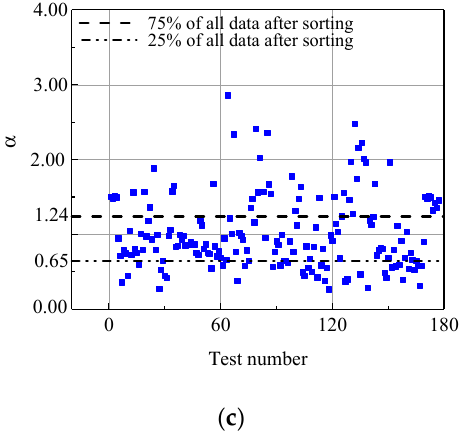
Figure 1. Soil properties of samples: wet density ( a ); plasticity index ( b ); D 50 ( c ); percent fines ( d ); Figure 2. Erodibility parameters of the excess stress shear model: the critical shear stress ( τ c ) ( a ); the erodibility parameters Z 0 ( b ); an empirical exponent α ( c ) . water content ( e